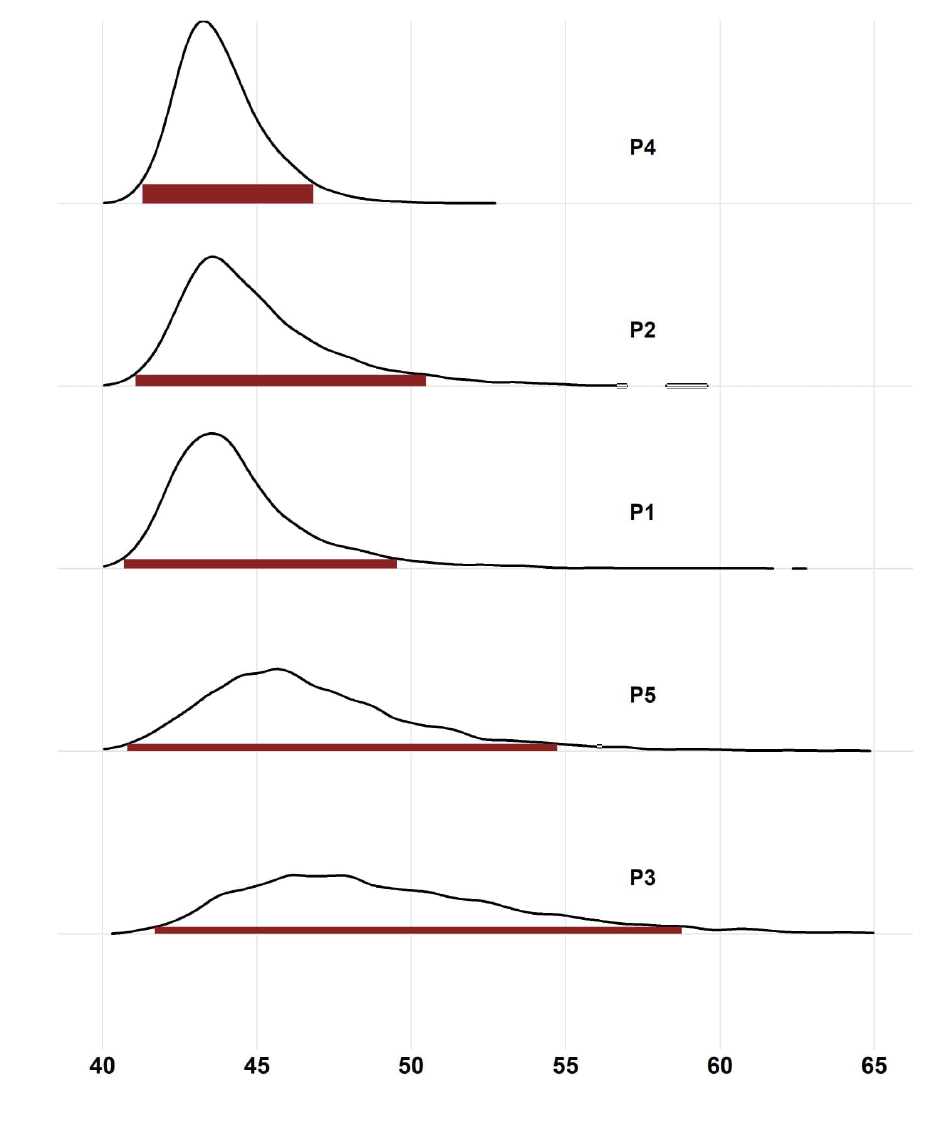
Figure 8. Posterior densities and highest posterior density intervals of the 20-year return levels (unit: km/h) obtained using the Bayesian estimation method with five priors (P1–P5) considered in the Section 4.2 for the annual maximum wind speed data at Udon Thani,